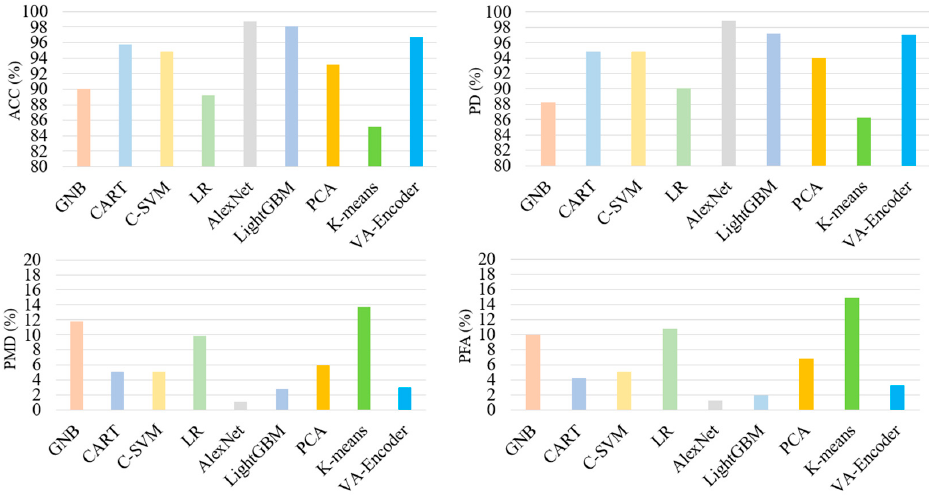
Figure 3. Performance evaluation of the ML models in terms of ACC , PD , PMD , and PFA for Test Data.